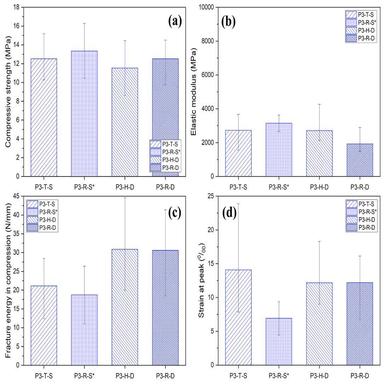
Mean values of compressive strength (a), elastic modulus (b), fracture energy in compression (c) and strain at peak (d) for single-wythe and double-wythe cores extracted from P3.